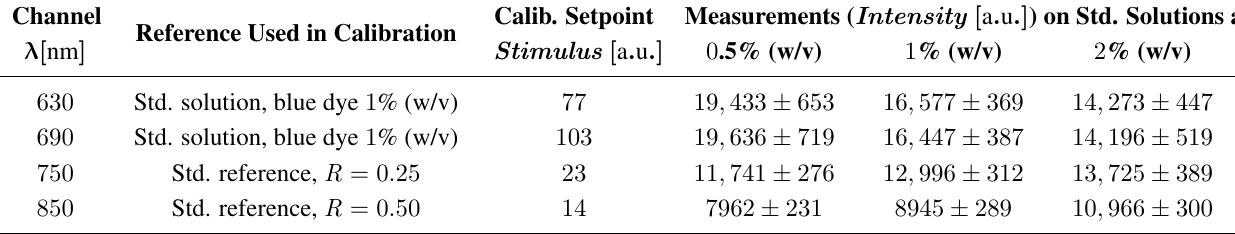
Table 3. Validation measurements on standard water solutions of blue dye at concentrations of 0 .5% (w/v), 1 % (w/v) and 2 % (w/v), respectively. Measurements on five repetitions in the table: Calib. = Calibration; Std. =